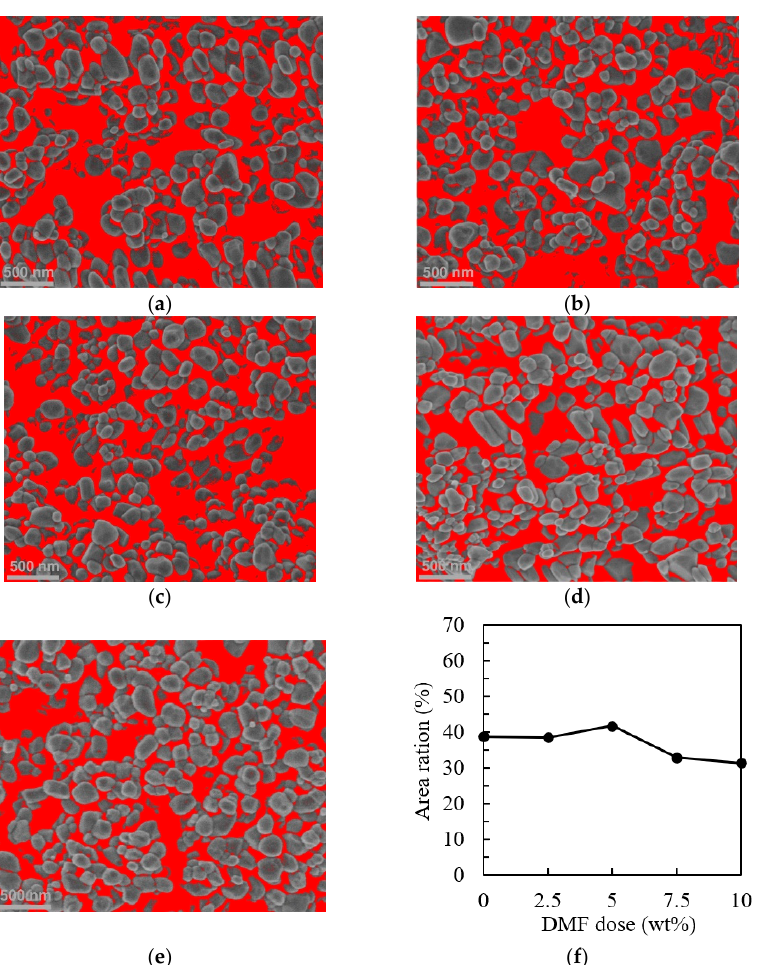
Figure 9. ( a – e ) The porosity characteristics of the samples prepared by injecting different DMF doses from 0 wt% to 10 wt%, and ( f ) the variation results. The cross-sectional and high-resolution transmission electron microscopy (TEM) im- ages of 350 °C-annealed TiO 2 films prepared without and with 7.5 wt% DMF are shown in Figure 10a,b, respectively. The cross-sectional layers observed from top to bottom are identified as glue, TiO 2 , FTO substrate, and SiO 2 , respectively. The corresponding selected area electron diffraction images inserted into right side identify the single-crystal-like structure of the porous TiO 2 films. The obvious variation of distances between bright spots is observed, proving the existence of Ti 3 O 5 phase-transition. The single-crystalline struc- ture is demonstrated with the calculated d-spacing value as the high-resolution images in the image of the right side. Based on the energy-dispersive spectrometer result, the area of relative element distribution (O, Sn, Ti, and Si) presents that the black circuit shape from the TEM is the real TiO 2 particle, as shown in Figure 11. In Table 3, the carbon content of the 350 °C-annealed samples with and without the 7.5 wt% DMF dose are 10.26 and 8.94 at%, respectively. Meanwhile, the nitrogen content of all samples is 0%. Compared to the expected stoichiometry of TiO 2 film, the 350 °C-annealed samples with and without the 7.5 wt% DMF dose show O-to-Ti (R O/Ti ) atomic ratios of 1.85 and 2.23, respectively. This result shows that the increased 1.32 at% carbon content caused by the DMF solvent,